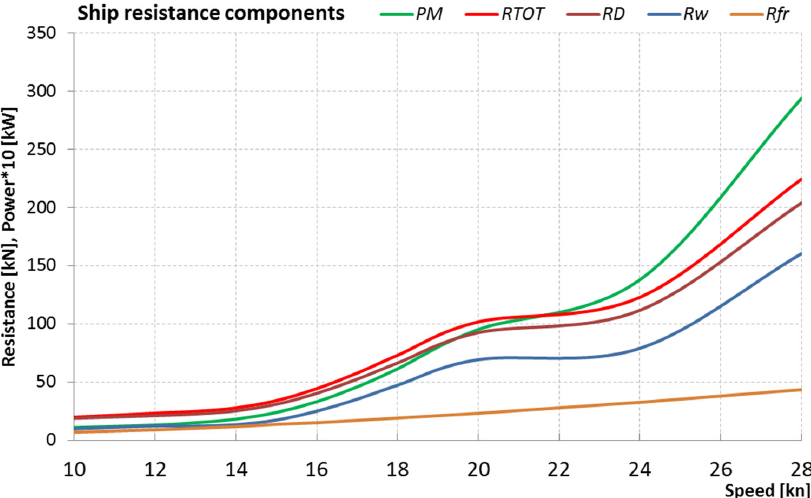
Figure 7. Approximate plot of total resistance depending on the longitudinal speed of the catamaran, where: P M —power of drive motor (kW); R TOT — total catamaran resistance (kN); R D — Resistances determined based on the Dubrovsky method (kN); R w — wave resistance (kN); R fr —frictional resistance of the wetted surfaces of catamaran hulls (kN).